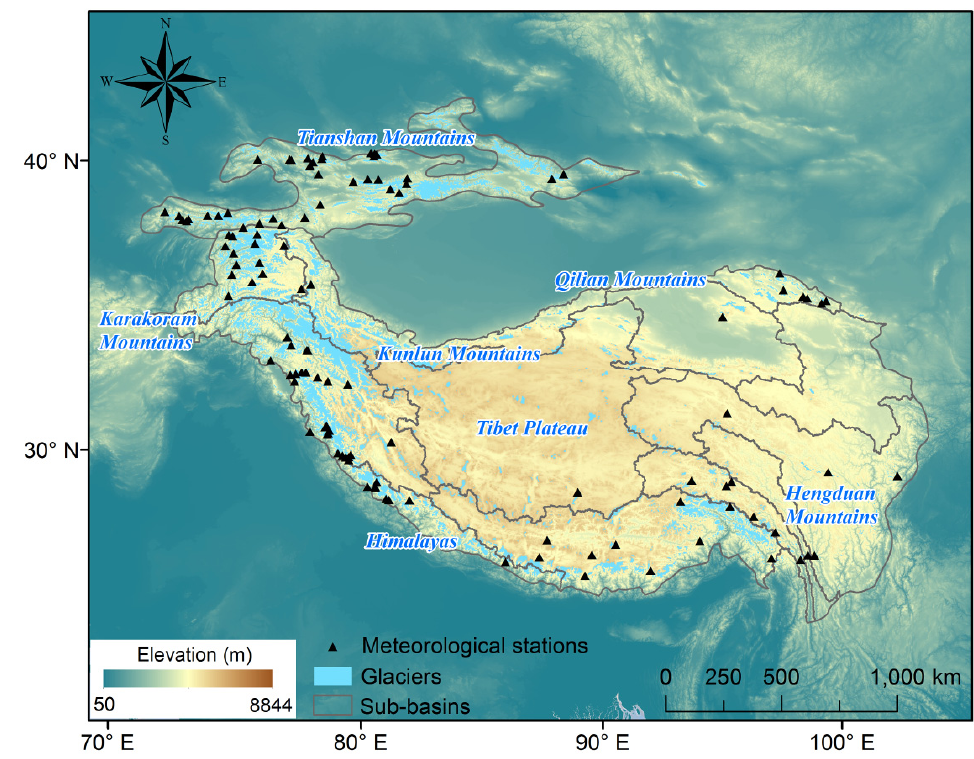
Figure 1. The location of sub-basins of High Mountain Asia (HMA). Glacier outlines are from the Randolph Glacier Inventory (RGI v6.0), the Second Chinese Glacier Inventory (CGI2), and the GAMDAM inventory, and are drawn in sky blue; the positions of the China Meteorological Administration (CMA) stations are indicated by black triangles.